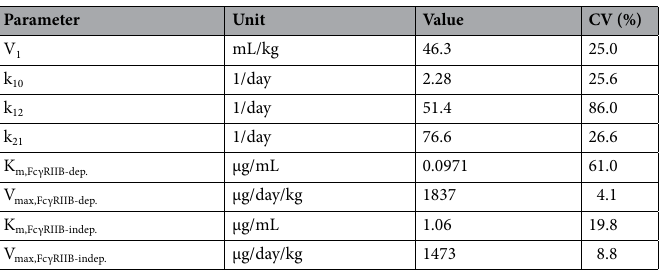
Table 1. PK parameters of the WT and FcγRIIB KO mice. The mean plasma concentration–time profile of the antibody of WT and FcγRIIB KO mice was simultaneously analyzed by the 2-compartment model with the Michaelis–Menten equation, and the target-independent PK parameters (V 1 , k 10 , k 12 , and k 21 ), and the parameters related to FcγRIIB-mediated elimination (K m,FcγRIIB-dep. and V max,FcγRIIB-dep. ), and the other FcγRs and unspecific non-linear elimination (K m,FcγRIIB-indep. and V max,FcγRIIB-indep. ) were